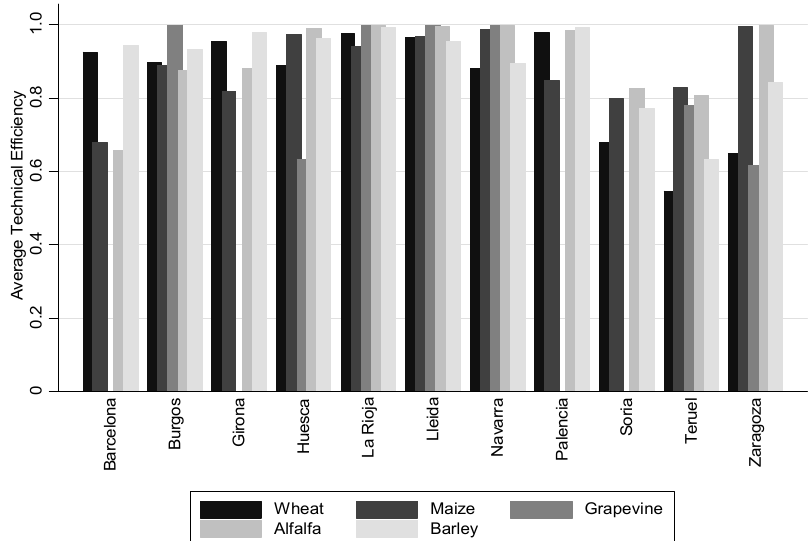
Figure 3. Predicted average technical efficiency by crop and